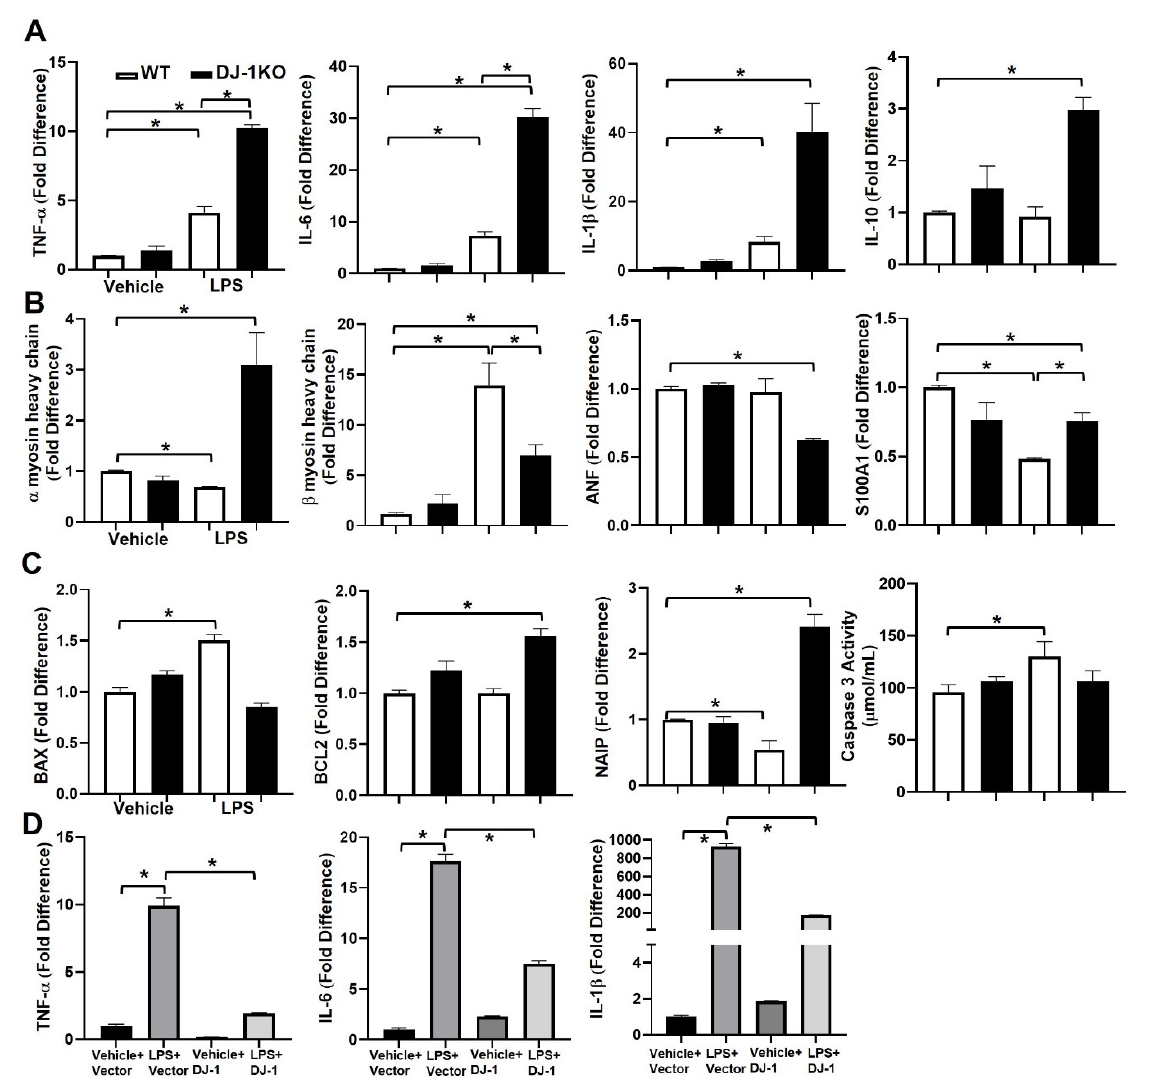
Figure 8. Loss of DJ-1 in cardiomyocytes exacerbates inflammation and represses hypertrophic signaling and apoptosis in response to LPS. ( A ) Bars are mean + SEM of TNF- α , IL-6, IL-1 β , or IL-10 mRNA expression/18S in cardiomyocytes derived from the myocardium of WT and DJ-1KO mice at treated for 24 h with LPS (1 µg/mL). ( B ) Bars are mean + SEM of aMHC, bMHC, ANF, or S100A1 mRNA expression/18S in cardiomyocytes derived from the myocardium of WT and DJ-1KO mice treated for 24 h with LPS (1 µg/mL). ( C ) Bars are mean + SEM of BAX, BCL2, and NAIP mRNA expression/18S or caspase 3 activity (mmol/mL) in cardiomyocytes derived from the myocardium of WT and DJ-1KO mice treated for 24 h with LPS (1 µg/mL). ( D ) WT cardiomyocytes were transfected with a DJ-1 expression plasmid or empty vector and treated 24 h later with vehicle or LPS (1 µg/mL) for an additional 24 h. Bars are mean + SEM of TNF- α , IL-6, and IL-1 β mRNA expression/18S. For all, n = 3/group. * p < 0.05.